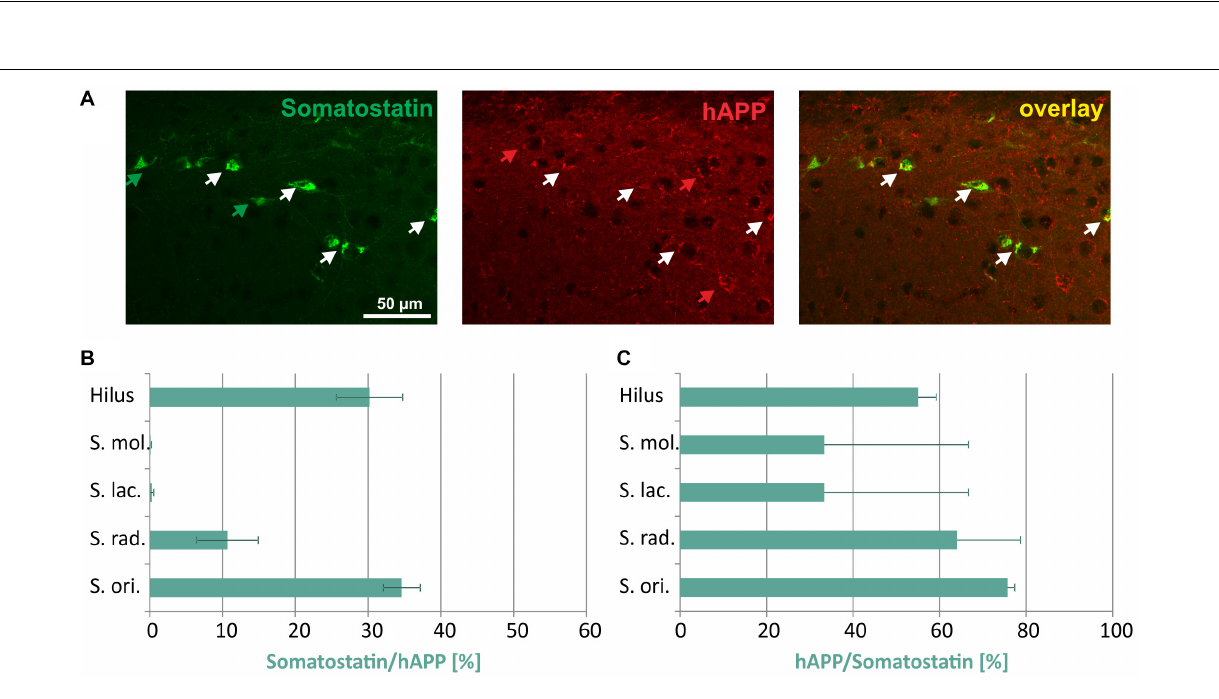
Frontiers in Neuroscience |